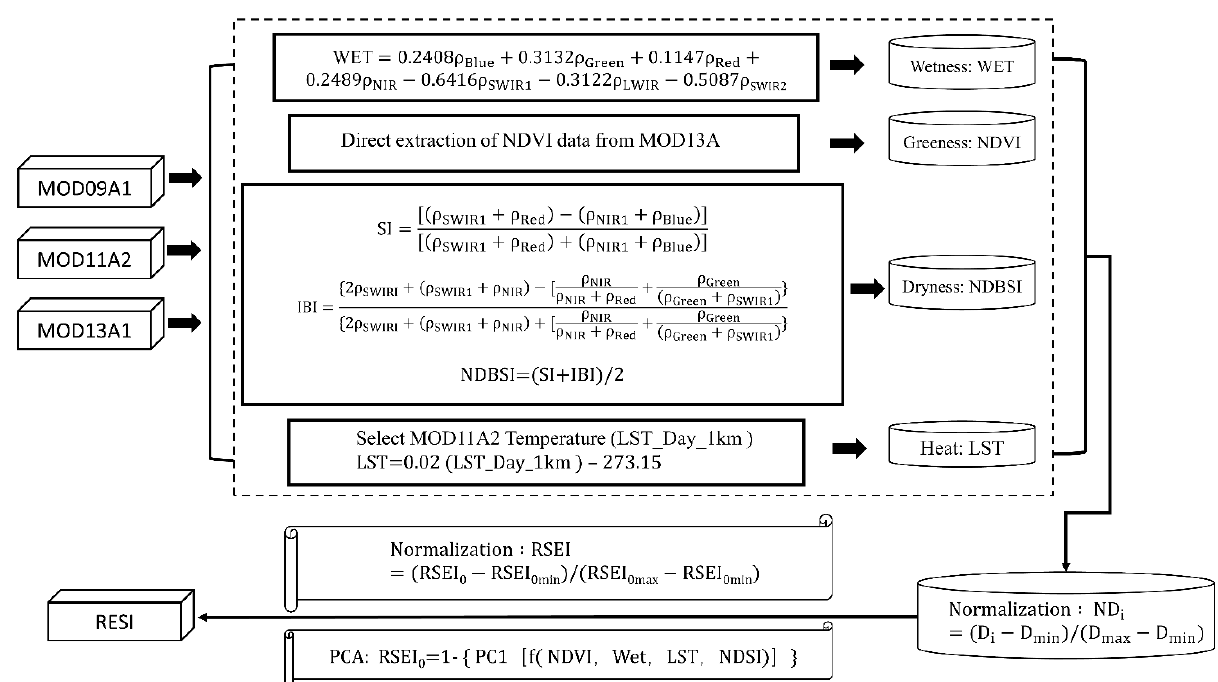
Figure 2. The flow chart of remote sensing ecological index